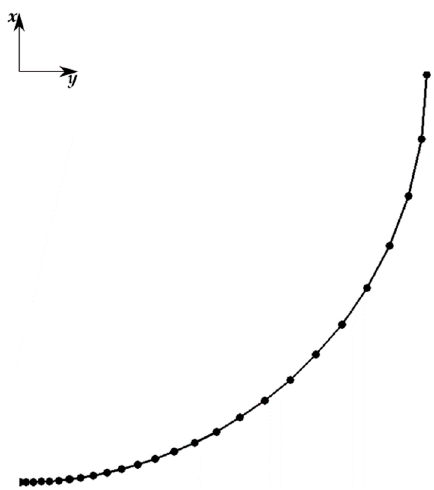
Figure 6. Section of the structural mesh of deformable cylindrical shell.